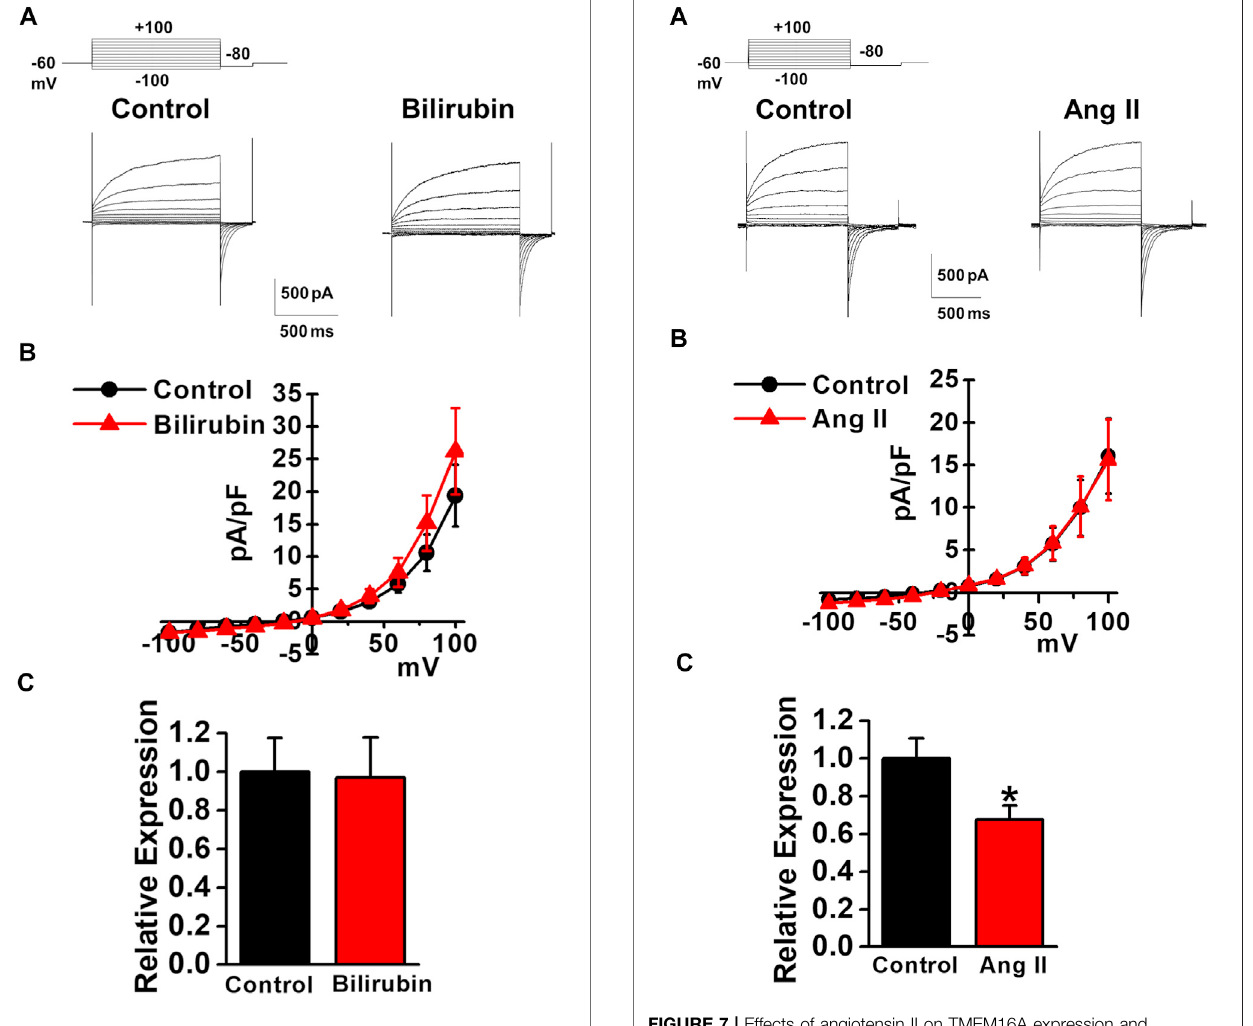
FIGURE 6 | Effects of bilirubin on TMEM16A activity in murine PVSMCs. Effects of bilirubin on the functional expression of TMEM16A channels were examinedinmurinePVSMCs. (A) RepresentativetracesofCl Ca currentsinthe absence and presence of 3 μ M bilirubin in PVSMCs. (B) Current-voltage (I-V) relationship of Cl Ca currents in the absence and presence of bilirubin in PVSMCs ( n = 7). (C) Expression level of TMEM16A mRNA in PVSMs after exposure to 30 μ M bilirubin for 24 h ( n = 9). Data are presented as means ± S.E.